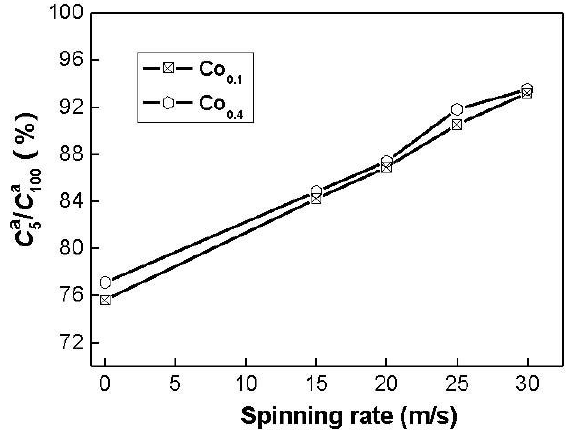
Figure 5. Evolution of the hydrogen absorption saturation ratio ( a R spinning